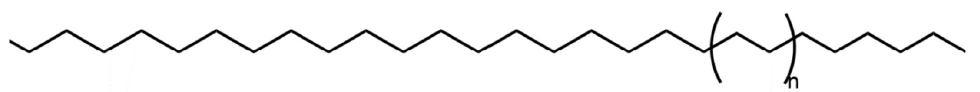
Figure 4. Chemical structure of paraffin wax. The molecule is a long chain of carbons and hydro- gens. The chemical formula of paraffin wax is C_ n H_((2 n + 2)), where n is between 20 to 40.